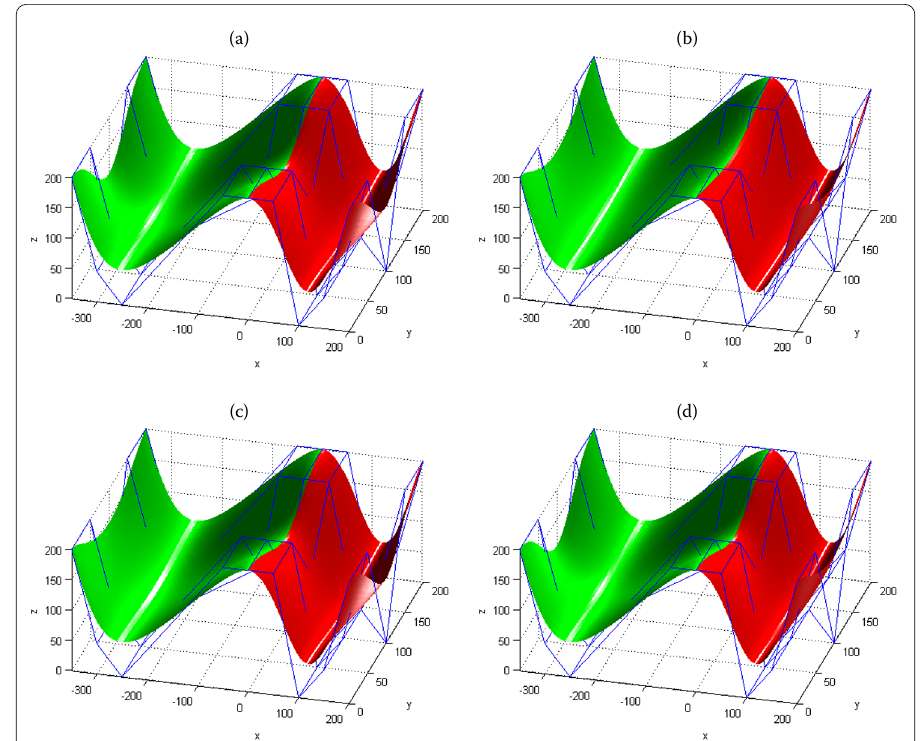
Figure 6 Shape modification of piecewise generalized Bézier-like surfaces with G 2 continuity in the v direction. (a) λ 1 = λ 2 = 1, γ i ,1 = γ i ,2 = 1 ( i = 0,1,2,3,4); (b) λ 1 = λ 2 = 1, γ i ,1 = γ i ,2 = –1 ( i = 0,1,2,3,4); (c)